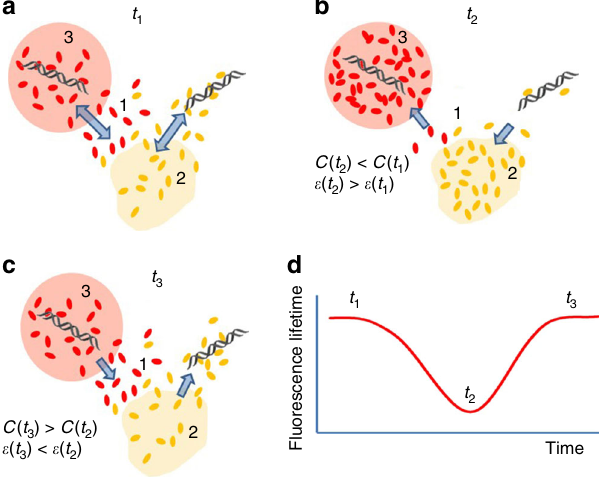
C ( t 3 ) > C ( t 2 ) (cid:2) ( t (cid:2) ( t 3 ) < 2 ) Fig. 5 Model for synchronous proteins condensation in nucleoli and nuclear speckles. Schematic representation of the protein shuttling between the nucleoplasm (1), nuclear speckles (2), and nucleolus (3). a Time point t 1 : Dynamic balance between the concentration of proteins in the nucleoplasm and nuclear organelles is maintained by condensation of proteins and their re-entrance of nucleoplasm. Nucleolar proteins are shown in red and proteins of the nuclear speckles are shown in yellow; equilibrium between proteins condensation and release is shown by arrows. b Time point t 2 : Nucleolar proteins are recruited from nucleoplasm to nucleolus at the onset of rRNA synthesis burst. Reduced concentration of proteins ( C ), is accompanied by an increase in dielectric constant ( ε ) of nucleoplasm, which stimulates protein condensation in the nuclear speckles. c Time point t 3 : at the end of rRNA synthesis burst, nucleolar proteins exit the nucleolus. Increased proteins concentration in the nucleoplasm is accompanied with decrease of ε , which triggers release of the proteins from the nuclear speckles. d Correspondence between the fl uorescent lifetimes of fl uorescent proteins in the nuclear organelles and the t – t 1 3 time